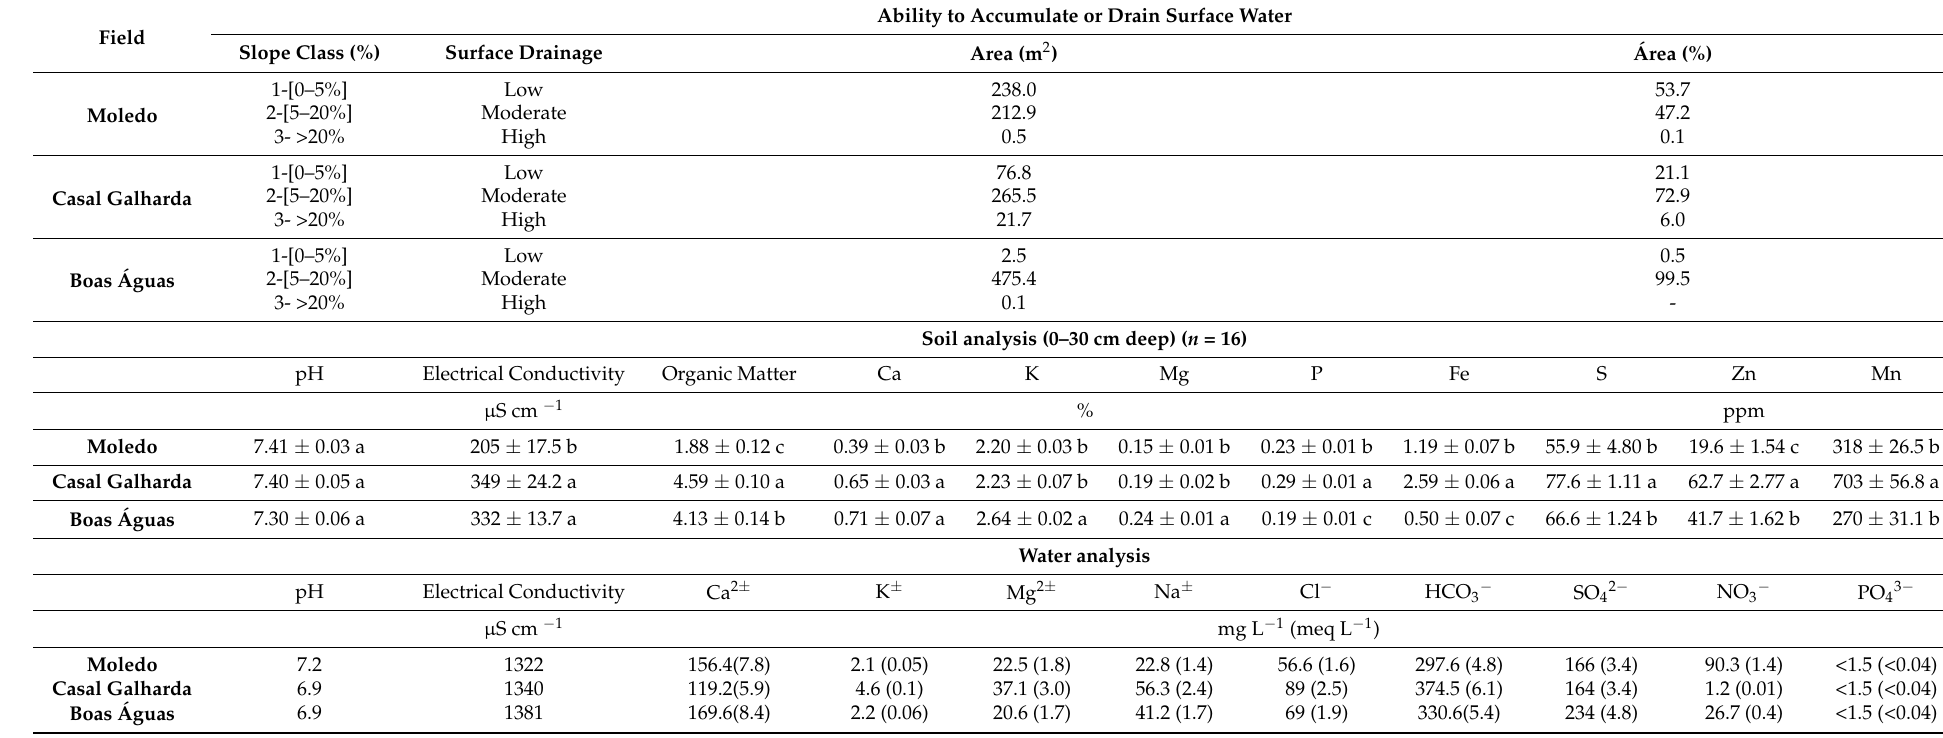
Table 1. Physical and chemical parameters of the soil and irrigation water of the experimental potato-growing fields Moledo, Casal Galharda and Boas Á guas) selected for Ca biofortification of Agria, Picasso and Rossi varieties,